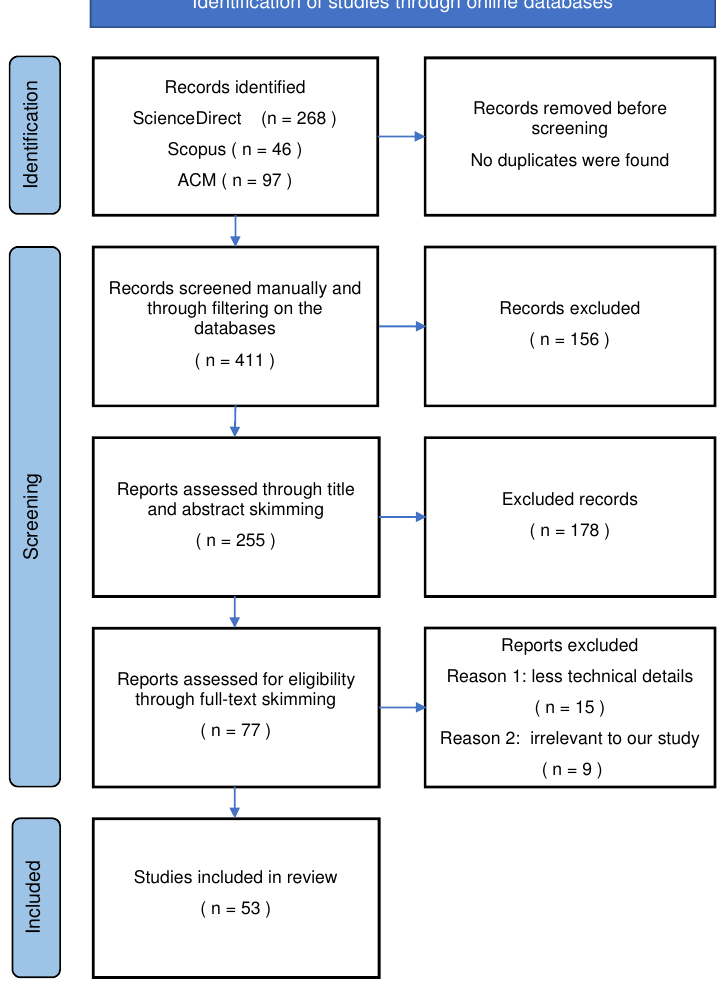
Figure 2. Search procedures for review papers and obtained results based on PRISMA